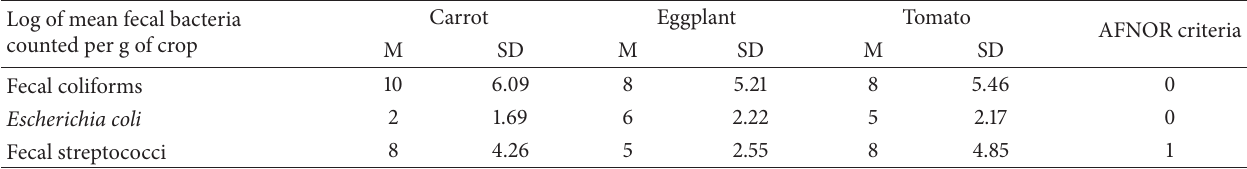
Table 2: Populations of fecal coliforms, Escherichia coli, and fecal streptococci on each crop (sites, growing periods, and fertilization treatments considered together) in comparison to AFNOR criteria (coastal area of Benin, 2009-2010, 288 plots, 96 samples of all crops). Carrot Eggplant Log of mean fecal bacteria counted per g of crop